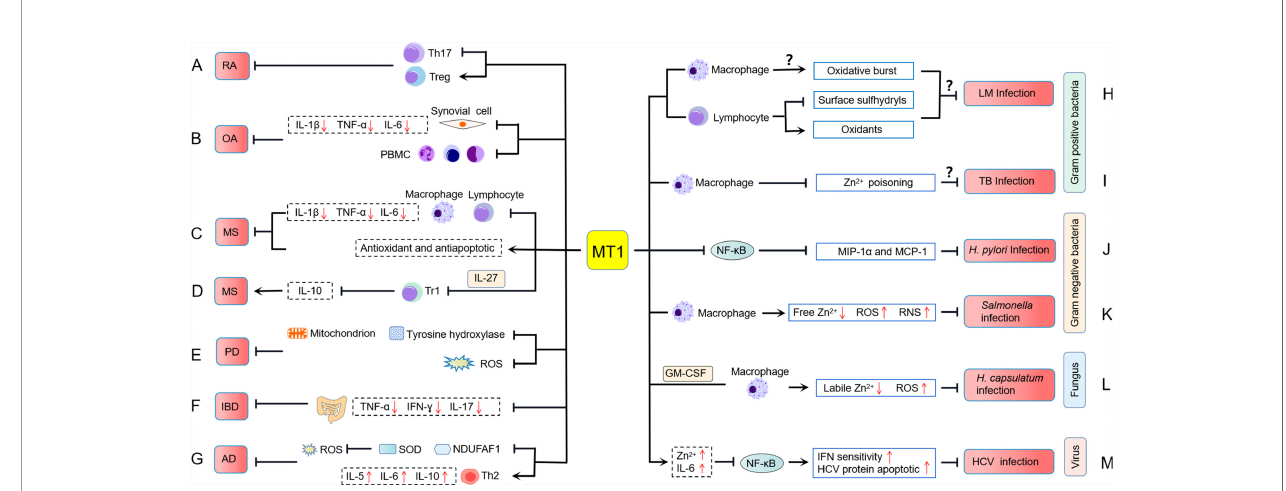
FIGURE 3 | MT1 is involved in the pathology of in fl ammatory diseases. (A) MT1 inhibits rheumatoid arthritis (RA) pathogenesis by altering the balance of Th17/Treg cell immune homeostasis. (B) MT1 plays an anti-in fl ammatory role by inhibiting the expression of IL-1 b , TNF- a , and IL-6 in PBMCs and synovial cells of erosive in fl ammatory osteoarthritis (EIOA) patients with an unclear molecular mechanism. (C) In multiple sclerosis (MS), MT1 suppresses the invasion of macrophages and lymphocytes into the CNS, downregulates the expression of proin fl ammatory cytokines, and increases the antioxidant and antiapoptotic capabilities of the host. (D) MT1 can promote the occurrence of MS by inhibiting the expression of IL-10 in IL-27-induced Tr1 cells. (E) MT1 plays a neuroprotective role in Parkinson ’ s disease (PD) through upregulating tyrosine hydroxylase expression, mitochondrial activity, and reducing ROS production. (F) MT1 restrains in fl ammatory bowel diseases (IBD) by suppressing proin fl ammatory cytokines production. (G) MT1 plays a protective role against atopic dermatitis (AD) development, which may rely on a SOD and NDUFAF1 mediated antioxidant mechanism and is accompanied by the upregulation of Th2-related cytokines. (H) MT1 in fl uences the oxidative burst in macrophages and the surface sulfhydryls and oxidants of lymphocytes upon Listeria monocytogenes (LM) infection, but the exact mechanism of MT1 modulating host defenses against LM infection is not clear. (I) MT1 may negatively regulate the occurrence of Mycobacterium tuberculosis (TB) infection by preventing zinc poisoning in macrophages. (J) MT1 can prevent Helicobacter pylori ( H. pylori )-induced pathological lesions by inhibiting NF- k B mediated MIP-1 a and MCP-1 expressions. (K) MT1 restrains Salmonella infections by suppressing free zinc levels and promoting the production of ROS and RNS. (L) MT1 controls Histoplasma capsulatum ( H. capsulatum ) infection in a manner that decreases labile Zn 2+ and increases ROS in GM-CSF-induced macrophages. (M) MT1 is implicated in the pathogenesis of hepatitis C virus (HCV) infection, which may be related to MT increasing zinc and IL-6 levels, leading to increased HCV protein apoptosis and IFN sensitivity by blocking NF- k B